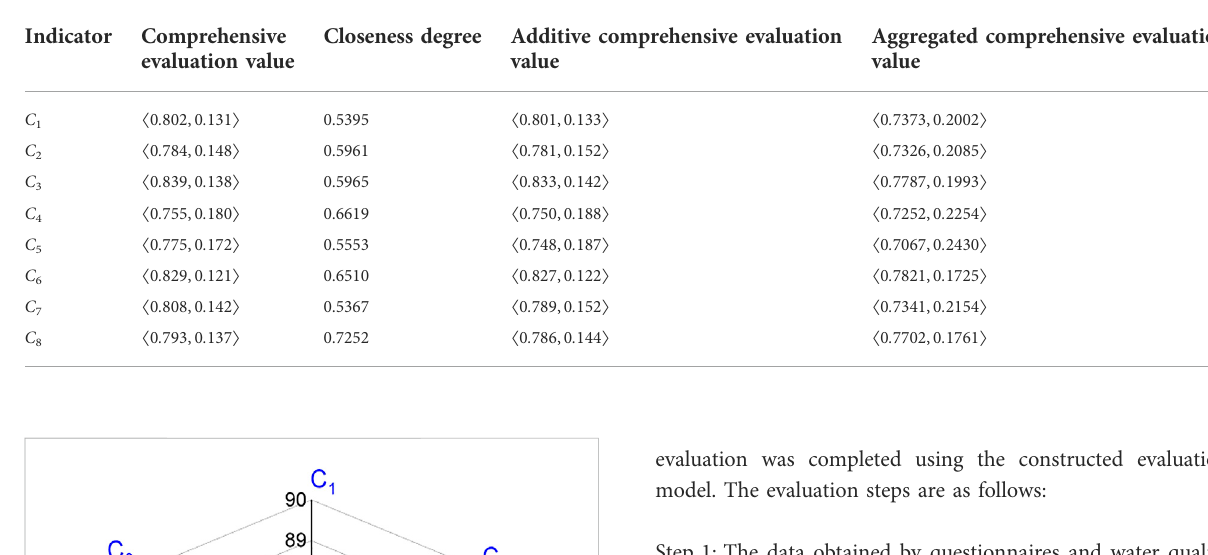
TABLE 5 Calculated results of Step 2 – Step 5.